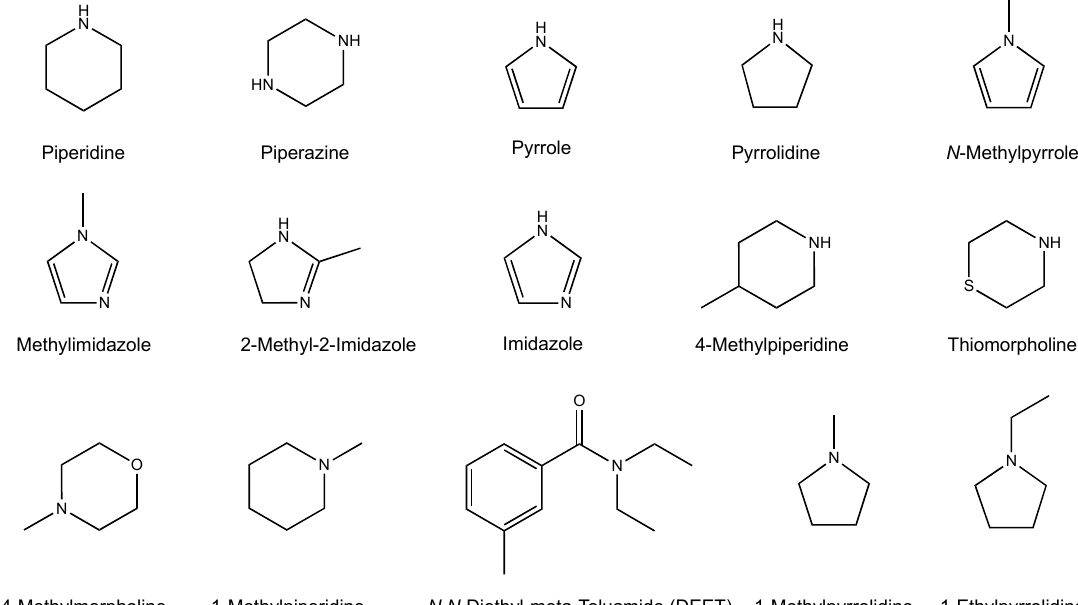
Figure 1. Chemical structures of parent heterocyclic amines, substituted pyrroles, substituted piperidines and DEET. Parent compounds: piperidine, piperazine, pyrrole, and pyrrolidine. Substituted pyrroles: N -methylpyrrole, 2-methylimidazole, 2-methyl-2-imidazoline, and imidazole. Substituted piperidines: 4-methylpiperidine, thiomorpholine, 4-methylmorpholine, and 1-methylpiperidine. Substituted pyrrolidines: 1-methylpyrroldine and 1-ethylpyrrolidine. DEET: N , N -diethyl- meta -toluamide.